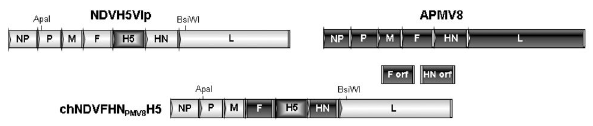
H5. Schematic Figure 1. Construction of chNDVFHN PMV8 representation of plasmid construction: The full length plasmid NDVH5Vlp was cleaved by Apa I and BsiW I and the resulting 8,568 nt fragment was inserted into a pUC18 derivative. This plasmid was altered by Phusion PCR using megaprimers coding for the F orf, HN orf of APMV-8, respectively to substitute the F- and HN orfs of NDV by those of APMV-8. Afterwards, the resulting plasmid DNA was cut with Apa I and